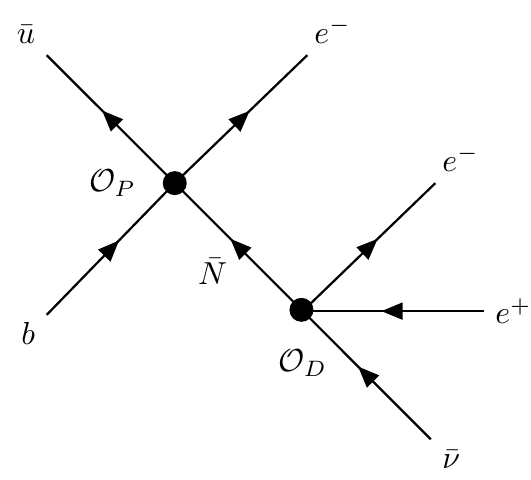
Figure 6 . Two-body B meson decay chain. O P is one of the three ¯ N production operators in eq. (2.5) and O D is one of the three ¯ N decay operators in eq. (3.2). The three-body B decay is the same but with ¯ u replaced by ¯ c